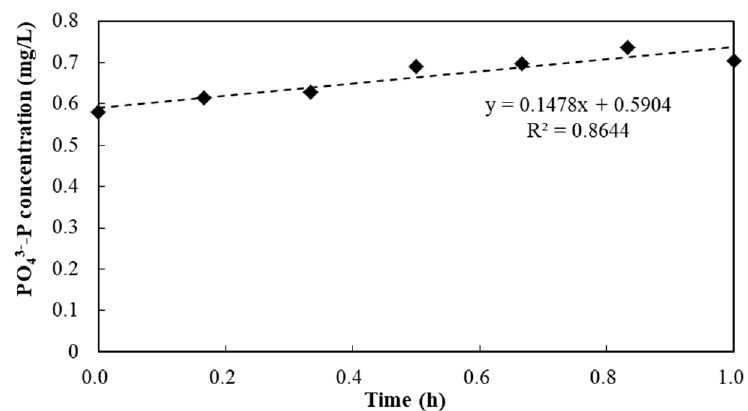
Figure 14. The phosphorus release rate of activated sludge in the CAST process. Microbial Community Structure